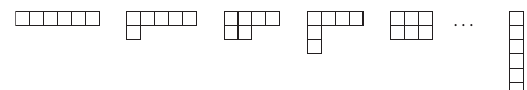
Figure 3: The Young diagrams of the partitions in (cid:3) 3.16 (cid:4) .